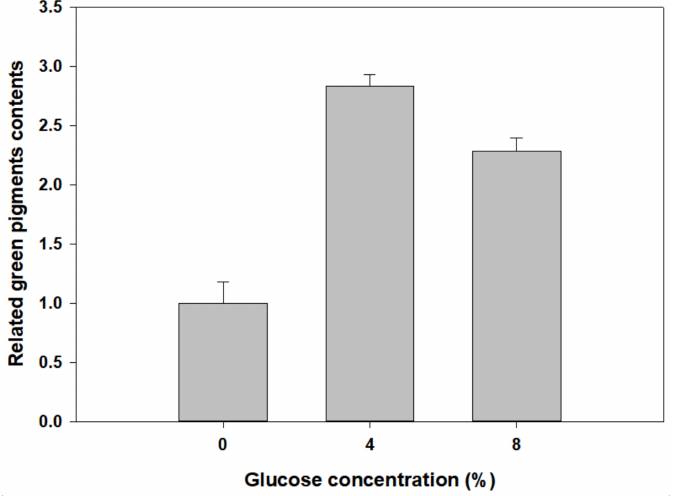
Figure 5. Variations in relative green pigment contents of 0% glucose-fed newly developed leaves of Pachira macrocarpa plants transferred to 0–8% glucose for another 2 weeks in complete darkness. Each data point represents the mean ± SE of four plants.